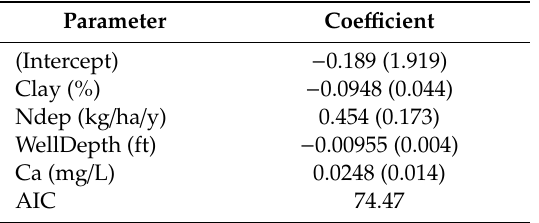
Table 2. Coe ffi cients of the Logistic Regression (LR) Model (Standard Errors are in